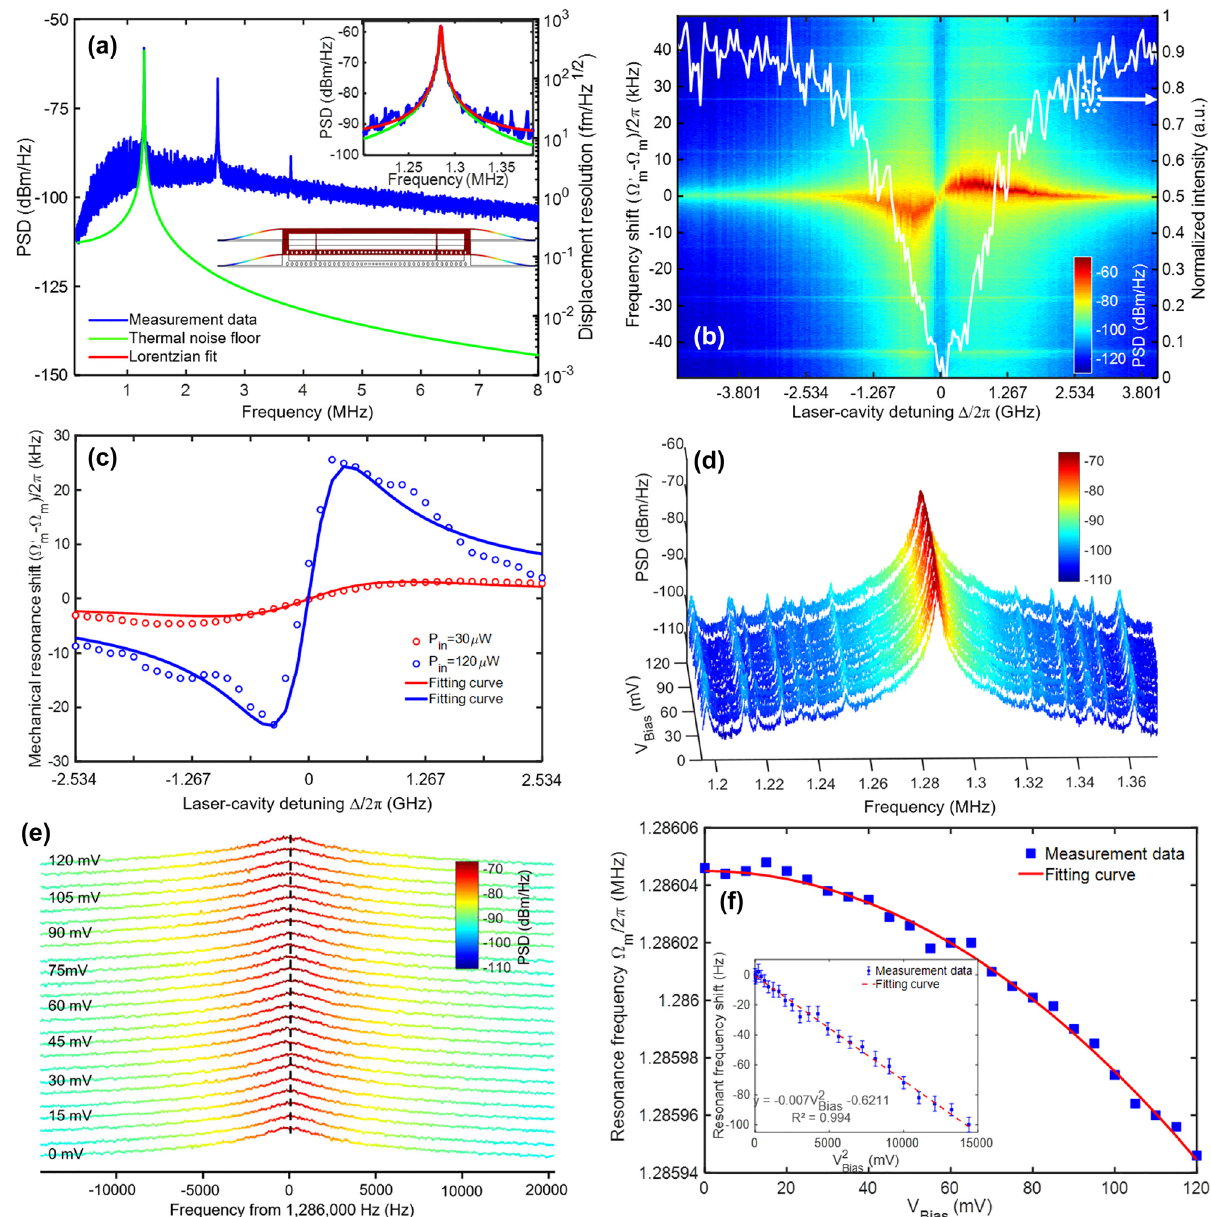
Figure 6: RF spectra of the optomechanical electrometer below the threshold power. (a) Measured RF spectrum of the fundamental in-plane mechanical mode of the moveable PCN (resolution bandwidth (RBW) of ESA is set at 100 Hz). Insets are FEM-calculated in-plane mechanical mode of the movable PCN and zoom-in view of the RF spectrum of the fundamental vibrating mode at Ω m / 2 π = 1 . 286 MHz, respectively. The blue-colored curve presents the measured data, the green-colored curve is the theoreticallycalculatedthermalnoise fl oor,andthered-coloredcurveistheLorentzian fi ttingcurveforthemechanicalresonantpeak.(b)PSD map of the measured RF spectrum as functions of laser-cavity detuning and mechanical resonance shift from the in-plane fundamental mode to verify the optical spring effect of the optomechanical electrometer. At the pump power of 30 μ W, the RF spectrum is obtained by sweeping through the TE 1,e resonance as plotted with the white-colored curve. (c) Mechanical resonance shift versus laser-cavity detuning for different pump powers. The discrete symbols denote the Lorentzian- fi tted peak frequencies from the measured data (15 μ W for red data points and 120 μ W for blue data points), and the red and the blue curves are the numerical modeled fi tting curves. (d) RF transduction at the pump power 30 μ W for measurement of applied voltages from 0 mV to 120 mV. (e) Zoom-in view of the RF peaks of the spectra under applied voltages. The black dashed curve indicates the variation of RF peaks as a function of the applied bias voltage. (f) Mechanical resonant frequency versus applied voltages. Inset is the measured data converted to a linear relationship between the resonant frequency shift and applied